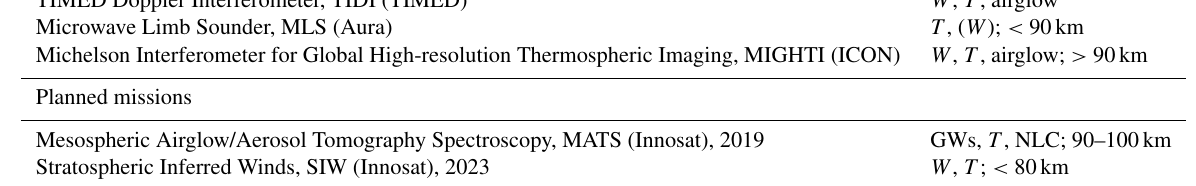
Second quarter of 2019 Main products